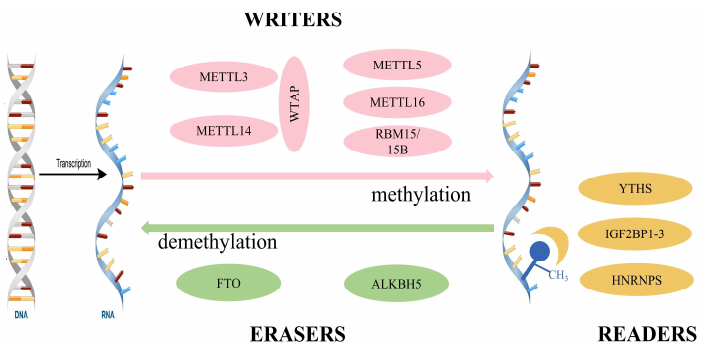
Figure 1. Regulators of m6A methylation. MTTL3, methyltransferase-like 3; WTAP, Wilms tumor 1-associated protein; RBM15/15B, RNA binding motif protein 15/15B; FTO, fat mass and obesity- related protein; ALKBH5, alkylation repair homologous protein 5; YTHS, YTDF homeodomain family proteins; IGF2BP1-3, insulin-like growth factor 2 mRNA binding protein; HNRNPS, heterogeneous ribonucleoproteins.